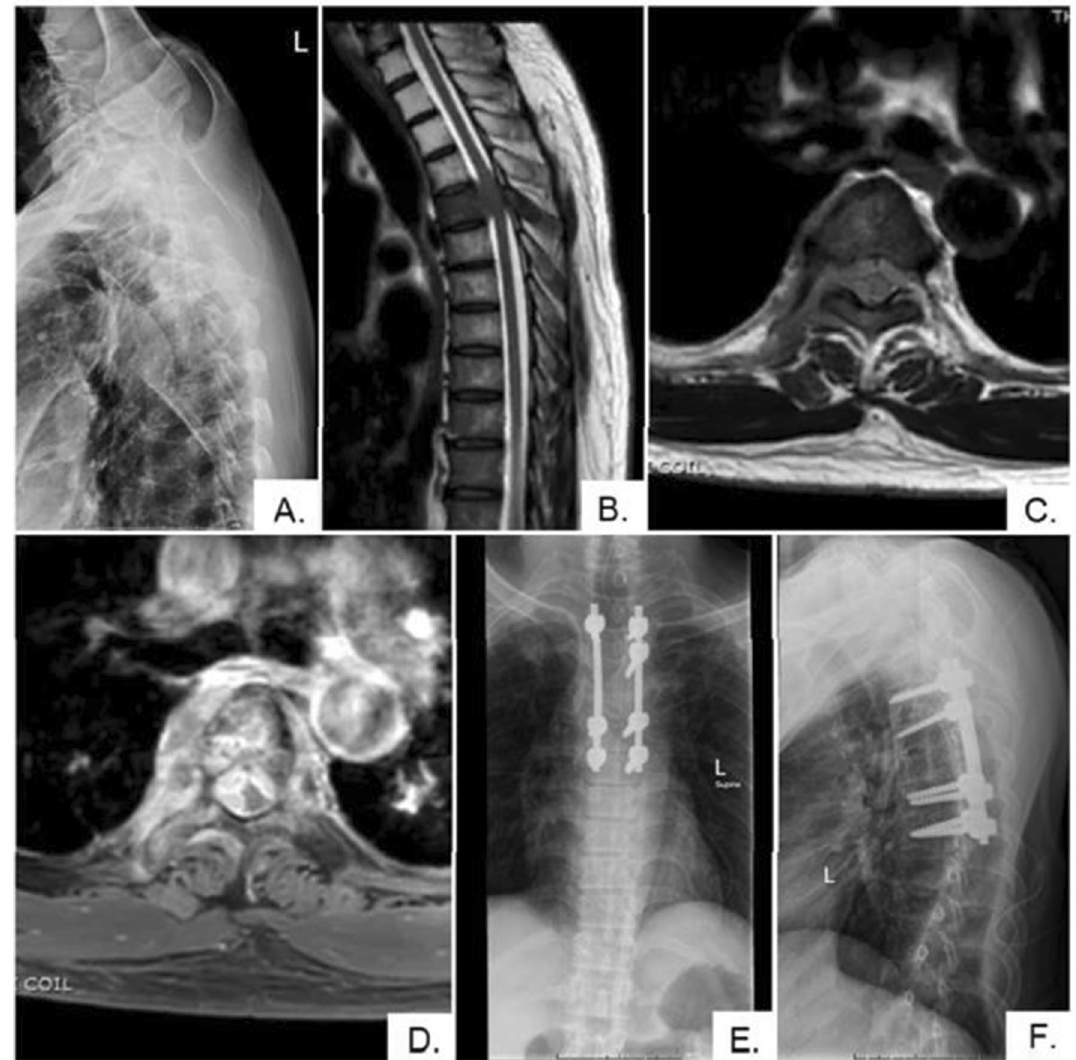
Figure 1. A 57-year-old male patient with tonsil cancer (case No. 14). ( A , B ) Lateral plain radiograph and sagittal T2-weighted magnetic resonance image (MRI) showing the mild collapse of the T5 vertebra and bone marrow involvement in the vertebral body due to metastases—extending posteriorly into the spinal canal compressing the spinal cord. ( C , D ) Axial T2-weighted and T1-weighted contrast-enhanced MRI confirm the tumor extension into the spinal canal. ( E , F ) Anteroposterior and lateral plain radiograph obtained 3 months after posterior instrumentation and decompression without anterior reconstruction, showing no implant-related complication. Please note that the tumor was already involved at the right T4 pedicle at the time of surgery. Thus, the surgeon was unable to insert the pedicular screw (VCFS) after the use of the spinal instability neoplastic score (SINS) prior to SRS in a metastatic spine. They found that patients with higher SINS were more likely to experience symptomatic fractures (31.6%) than those with lower SINS (7.4%). Furthermore, high SINS was a significant risk factor for VCFs after this non-surgical treatment on univariate and multivariate analysis. Therefore, this could also raise the importance of surgical treatment as a valid option in our patients’ who mostly present with high SINS, which means spinal instability. Palliative surgery is one of the treatment modalities of choice in selected patients, intending to achieve adequate spinal cord decompression and stabilization of the metastatic spine 19 . The posterior approach is still the most popular option in the thoracic and lumbar spinal regions due to its simplicity and surgeon familiarity 2 . Several authors have suggested adding anterior reconstruction and/or fusion procedures to achieve even more circumferential decompression and stability. In 2004, Lewandrowski et al. 5 reported a case series of 30 patients with primary spinal bone tumor or metastasis treated by anterior vertebral reconstruction with fresh-frozen cortical bone allograft with anterior and posterior instrumentation. Despite the high rate of intraoperative or postoperative complications (up to 46%), the authors proposed the anterior column reconstruction technique as being a reliable technique for treating patients with spinal tumors. Jandial et al. 8 conducted a retrospective case review of 11 patients with spinal metastasis who underwent single-stage posterior-only vertebral column